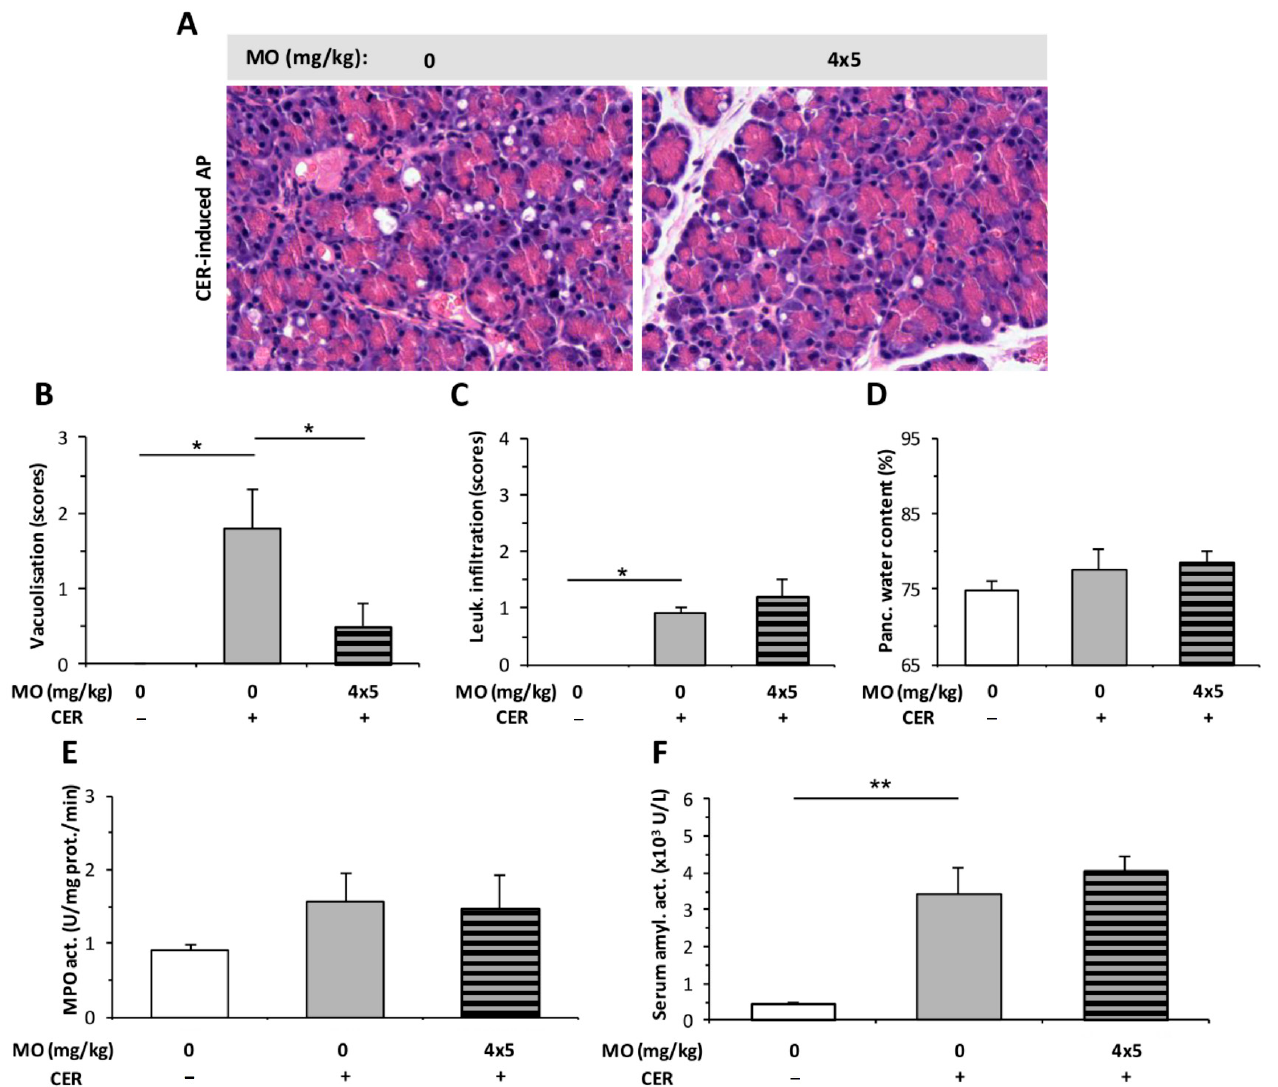
Figure 7. Morphine (MO) treatment does not affect the severity of cerulein (CER)-induced acute pancreatitis (AP). Rats were treated with 4 × 5 mg/kg MO i.p., whereas 4 × 20 µg/kg CER (CER +) was used i.p. to induce AP. Control animals received physiological saline instead of CER (CER − ) or MO (0 mg/kg). Animals were sacrificed at 12 h after the first CER or physiological saline injection. ( A ) Representative histopathological images of pancreatic tissues of the treatment groups. Bar charts show the extent of pancreatic ( B ) vacuolization, ( C ) leukocyte infiltration, ( D ) water content, ( E ) myeloperoxidase (MPO) activity, and ( F ) serum amylase activity measurements. Values represent mean with standard error, n = 6. Two-way ANOVA was performed followed by the Holm–Sidak post hoc test. * p < 0.05; ** p < 0.001. Scale bar.